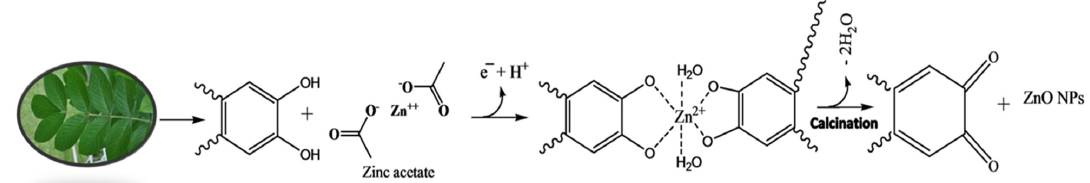
Figure 5. Biosynthesis of ZnO NPs using L.specioca leaves [72].